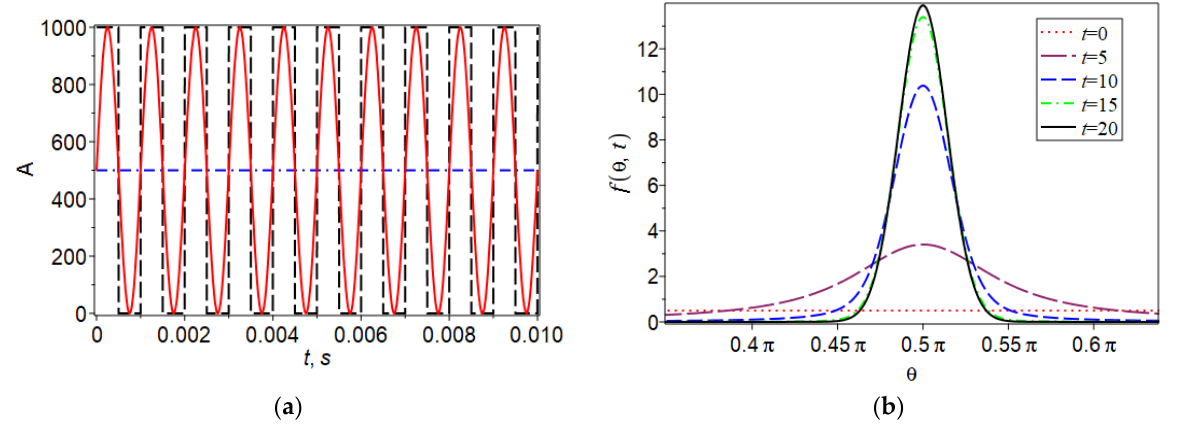
Figure 6. (Color online) ( a ) Intensity pulses of the exposure radiation. ( b ) Evolution of the probability density functions for different modes of the exposure radiation with identical mean intensities.